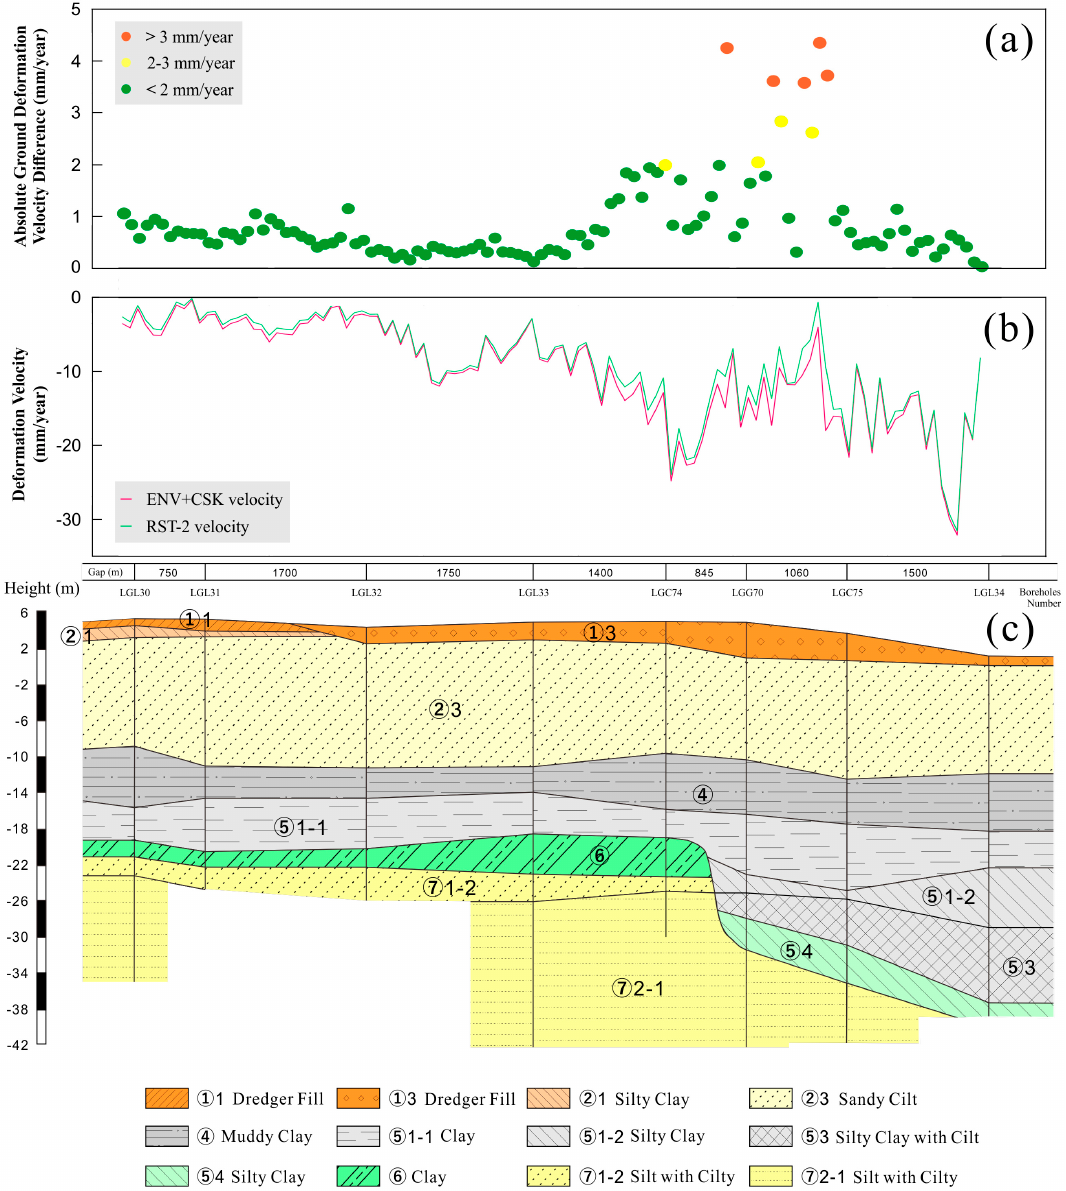
Figure 10. Sub-soil characteristics of the Lingang New City area. ( a ) Scatter diagram of the absolute value of the difference between the ENV+CSK velocities and RST-2 velocities over the I-I’ profile. The average absolute value of the difference between the modeled and the measured RST-2 mean ground- deformation values were also calculated, and it equals 0.89 mm/year. ( b ) Plots of the ENV+CSK ground deformation velocities and the measured RST-2 ground deformation velocities over the I-I’ profile. ( c ) The profile of engineering geologic layers from I to I’ (refer to [47]).